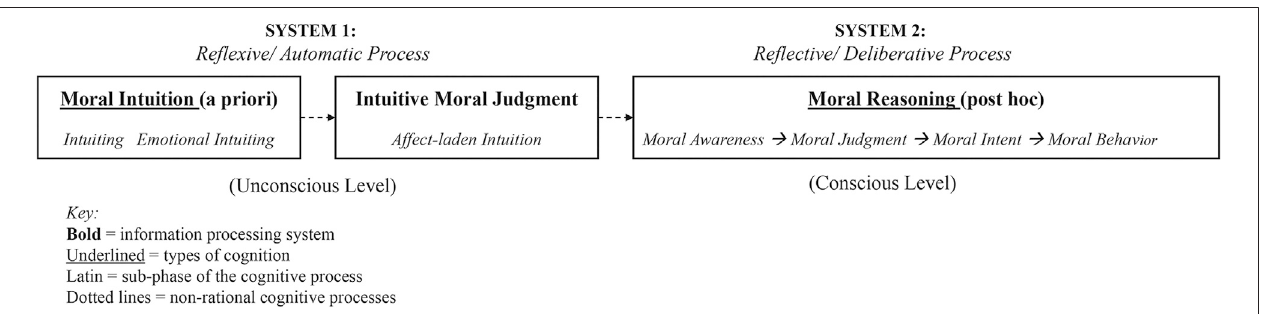
Frontiers in Robotics and AI |